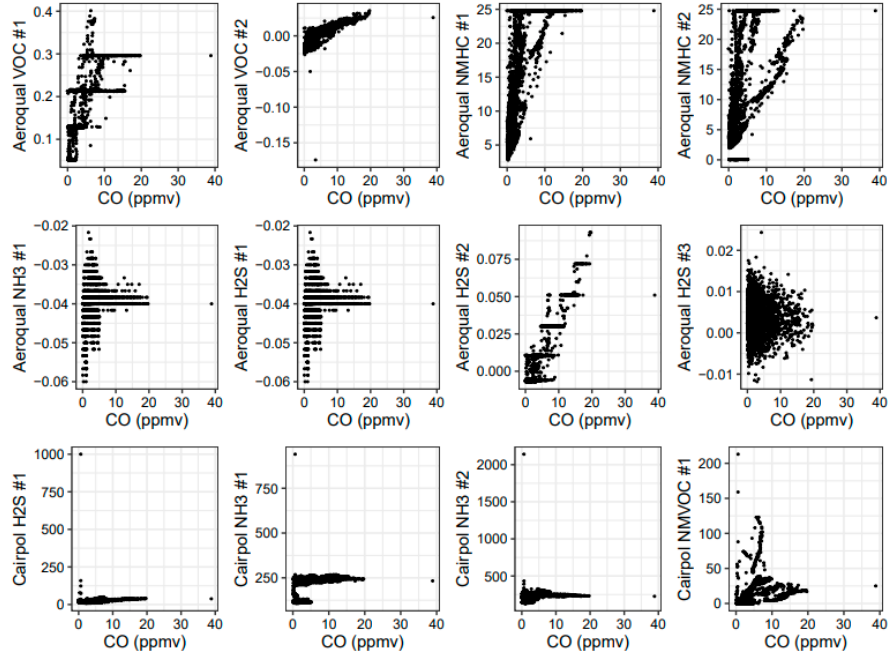
Figure 13. Scatterplot of Aeroqual VOC, NMHC, H 2 S, and NH 3 sensors and Cairpol H 2 S, NH 3 , and NMVOC sensors versus CO for the combined Fire Sciences Laboratory burns in 2018.